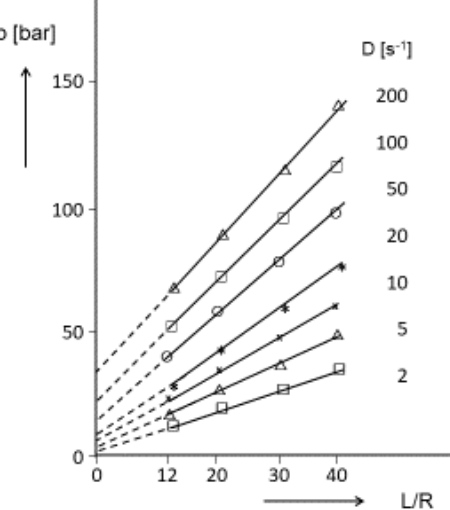
Figure 12. Extrusion pressure p as a function of the length to radius ratio L / R of a capillary for a commercial polystyrene at different apparent shear rates 𝐷.